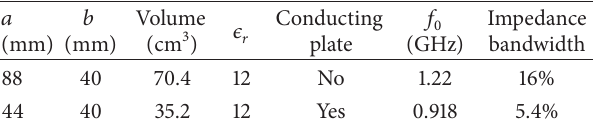
permittivity ( 𝜖 𝑟 = 100 ) is presented. It is demonstrated that, Table 3: Effect of the miniaturization of a rectangular DRA [23].